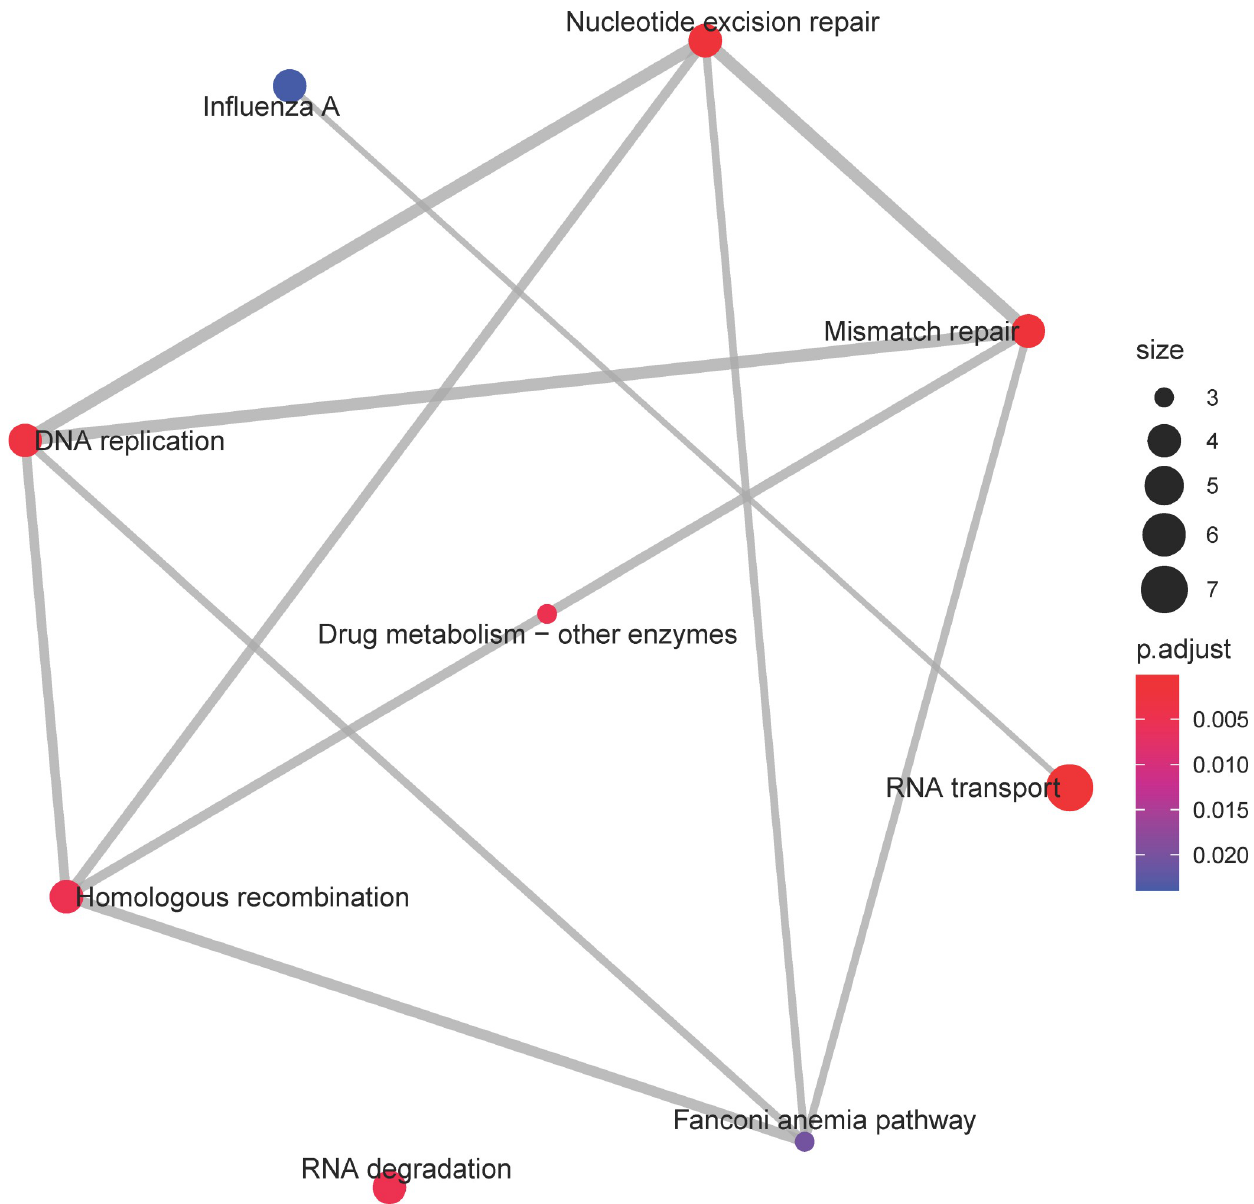
Fig 6. Enrichment map of Kyoto Encyclopedia of Genes and Genomes (KEGG) pathways for the darkgreen consensus co-expression module. Symbol explanation as in Fig 4. Several pathways dealing with nucleic acid metabolism, such as DNA replication and RNA degradation are significant in this pathway. The expression trend of this module increased linearly until age 10 months after which it stabilized, suggesting increasing activity of these pathways until a stable activity level is reach in old age.